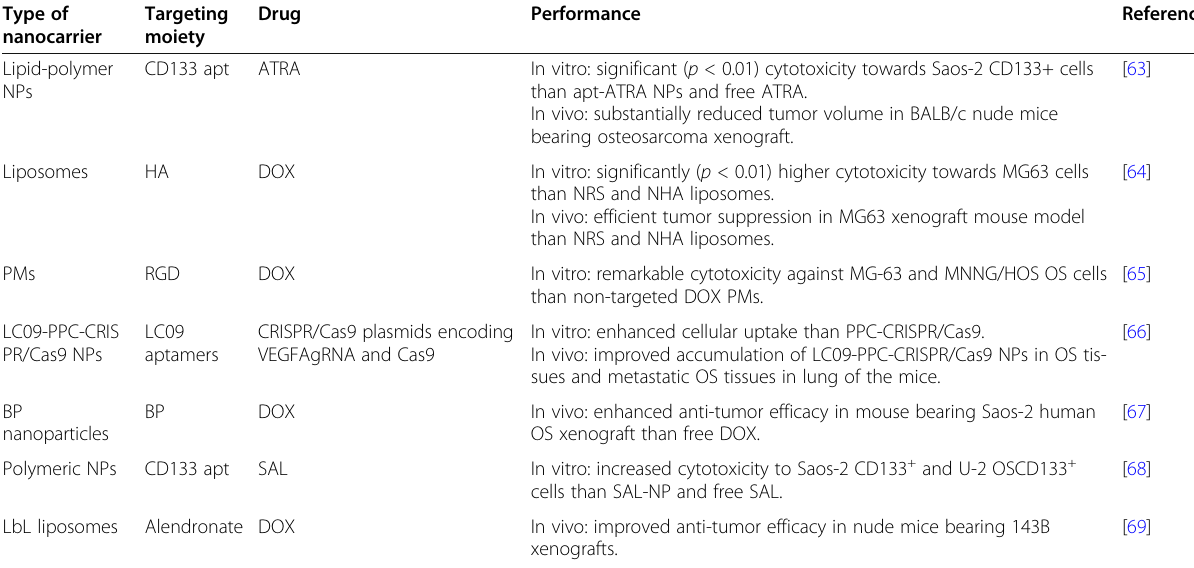
Table 3 Active targeted NPs reported for osteosarcoma treatment Type of